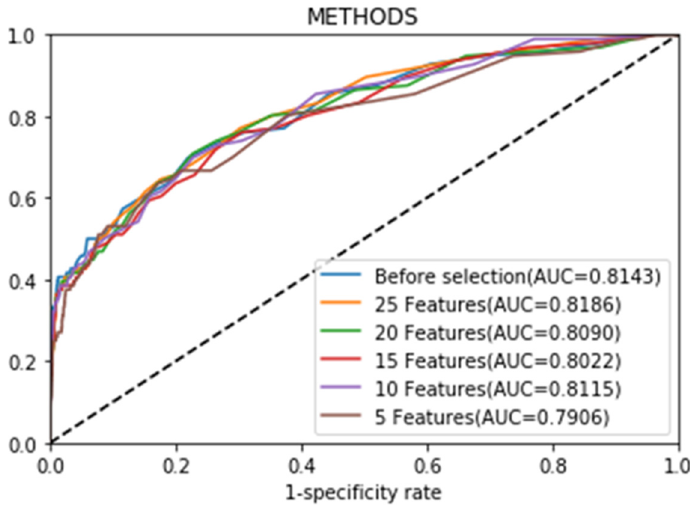
Figure 4. AUC curve of prediction models with different numbers of features. AUC, area under curve.